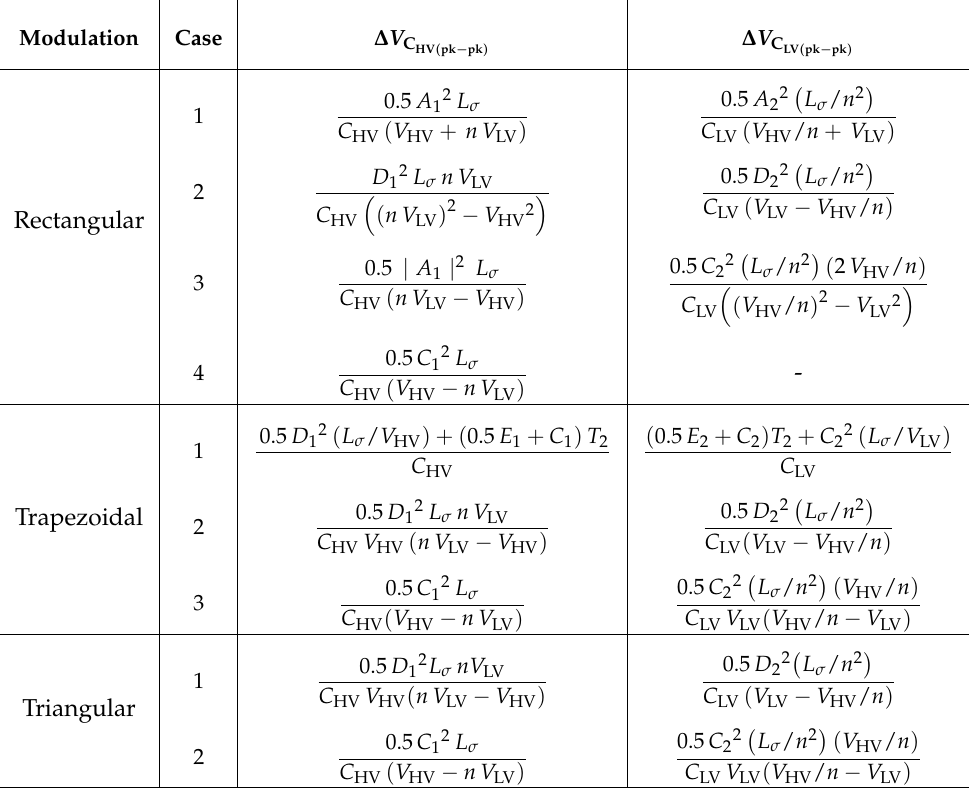
Table A1. Voltage ripple in input and output capacitor (power transfer from HV to